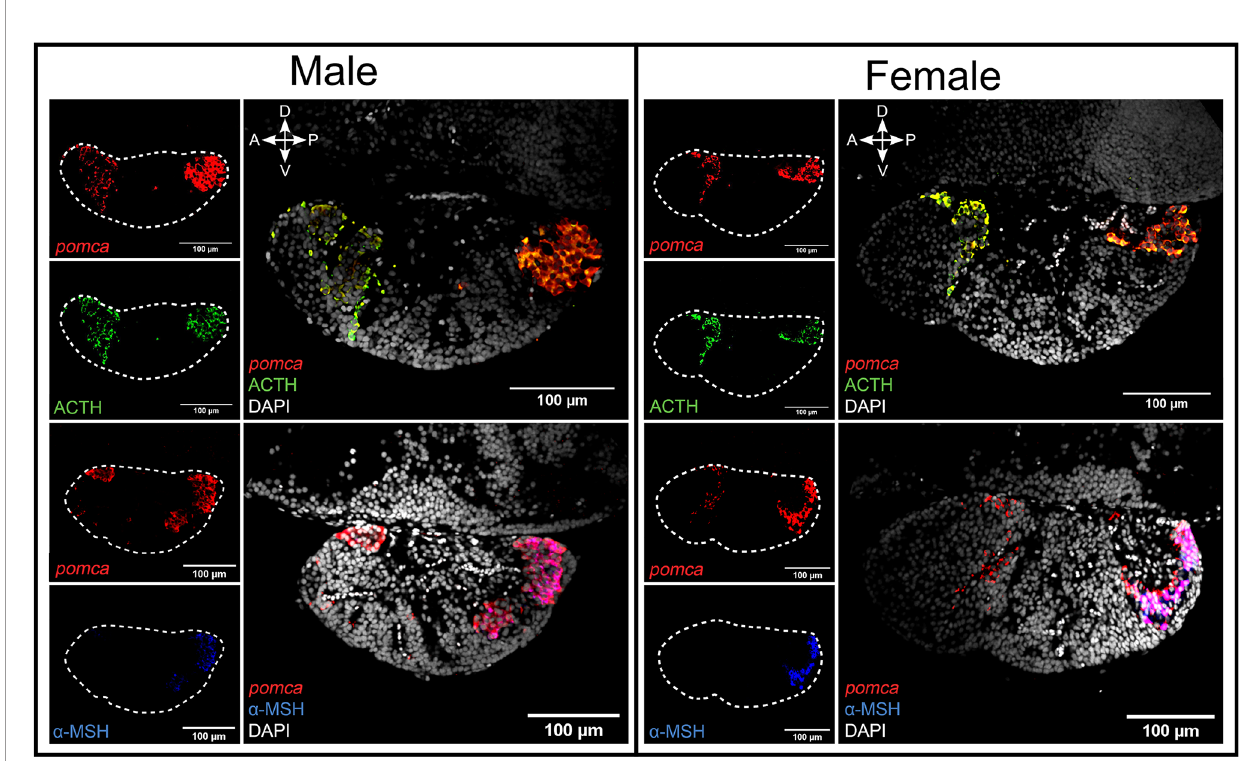
FIGURE 2 | The combination of FISH for pomca and IF for Acth or a -Msh allows the distinction of two clear pomca expressing cell populations. The distinction of Acth (green) and a -Msh (blue) producing cells from pomca -labelled (red) in the pituitary from adult male and female medaka. The dashed lines represent the pituitaries shown in the right panel. Four direction arrows display the direction of the pituitary (A, anterior; P, posterior; D, dorsal; V,